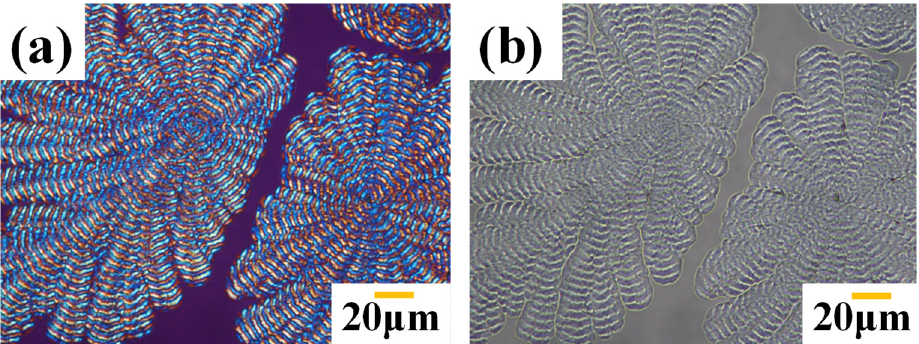
Figure 12. Comparative graphs of ( a ) POM and ( b ) OM for fractal-dendritic banded PPDO at T c = 78 °C [crystallized from PPDO/PVPh (75/25)].